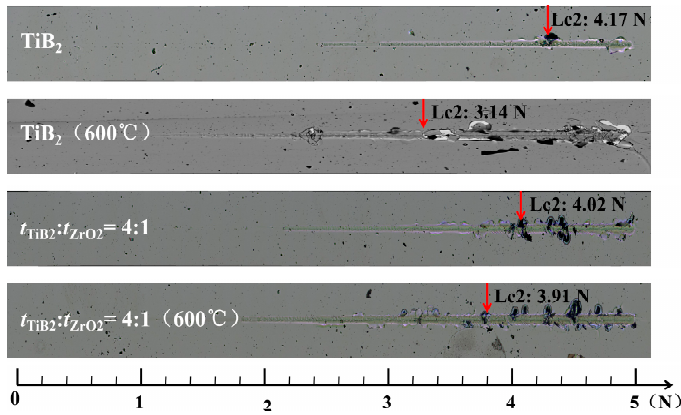
= 4:1) multilayers before : t ZrO 2 2